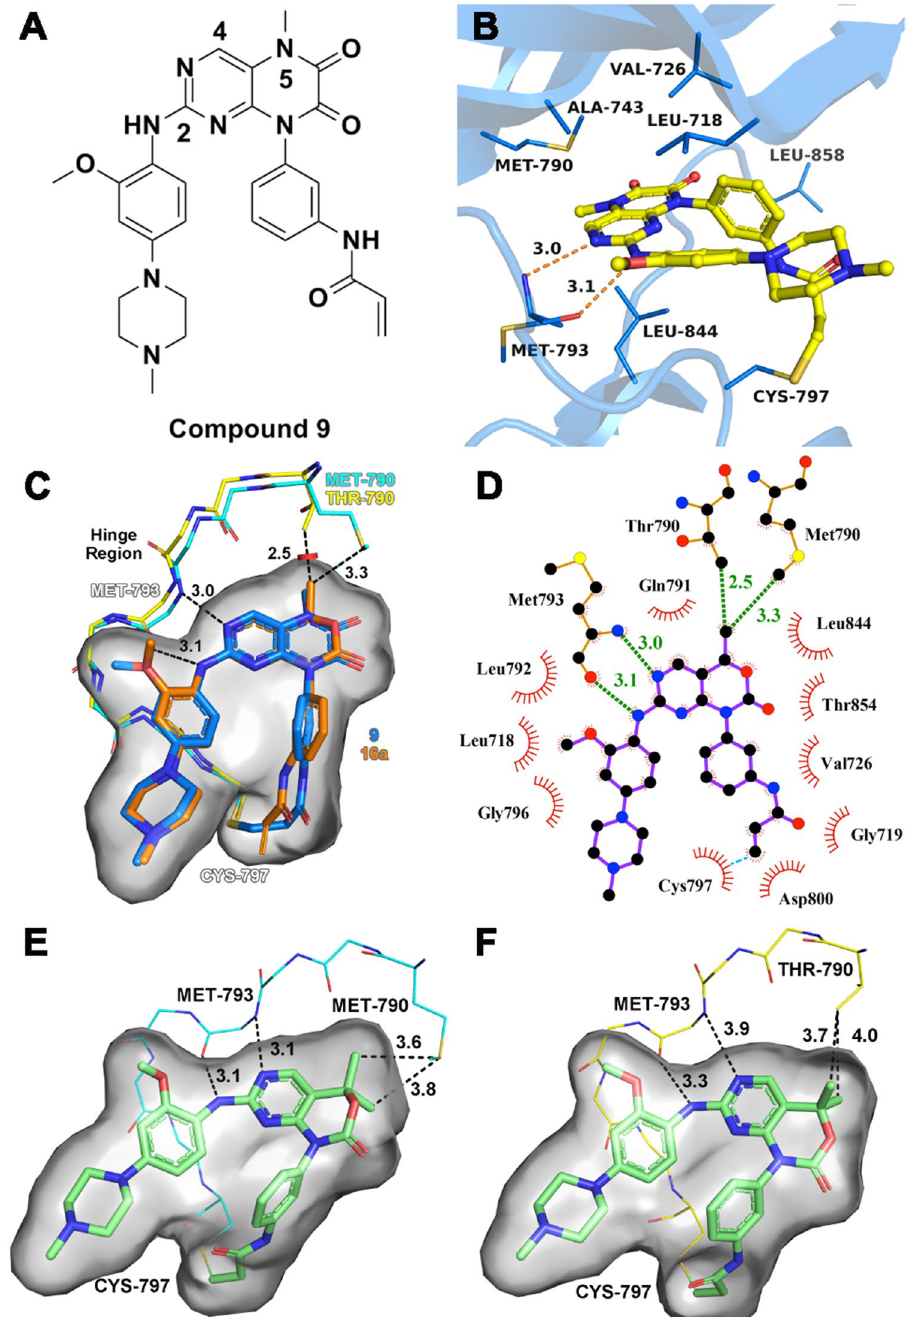
Figure 2. ( A ) The chemical structure of compound 9 . ( B ) The modeling binding mode of compound 9 bound to EGFR T790M (PDB code: 3IKA). The sulfur atoms are colored in dark yellow and the carbon atoms are colored in light yellow. ( C ) The design strategy of C4-alkyl-1,4-dihydro-2 H -pyrimido[4,5- d ][1,3]oxazin-2-ones scaffold. Compound 16a (orange) was aligned to the modeled conformation of compound 9 (marine) shown in panel A by SHAFTS. The EGFR WT crystal structure (shown in yellow, PDB code: 4G5J) was aligned to the EGFR T790M (shown in cyan, PDB code: 3IKA). The hinge regions of both EGFR WT and EGFR T790M were presented as stick. The carbon atoms of 9 are colored in marine and the nitrogen atoms of 9 are colored in dark blue. ( D ) The 2D diagram interaction of compound 16a . ( E ) The proposed binding mode of compound 20a bound to EGFR T790M (cyan line, PDB code: 3IKA). ( F ) The proposed binding mode of compound 20a bound to EGFR WT (yellow line, PDB code: 4G5J). The conformations of compound 9 , 16a and 20a in the panel C,E and F are depicted as stick and highlighted in grey surface